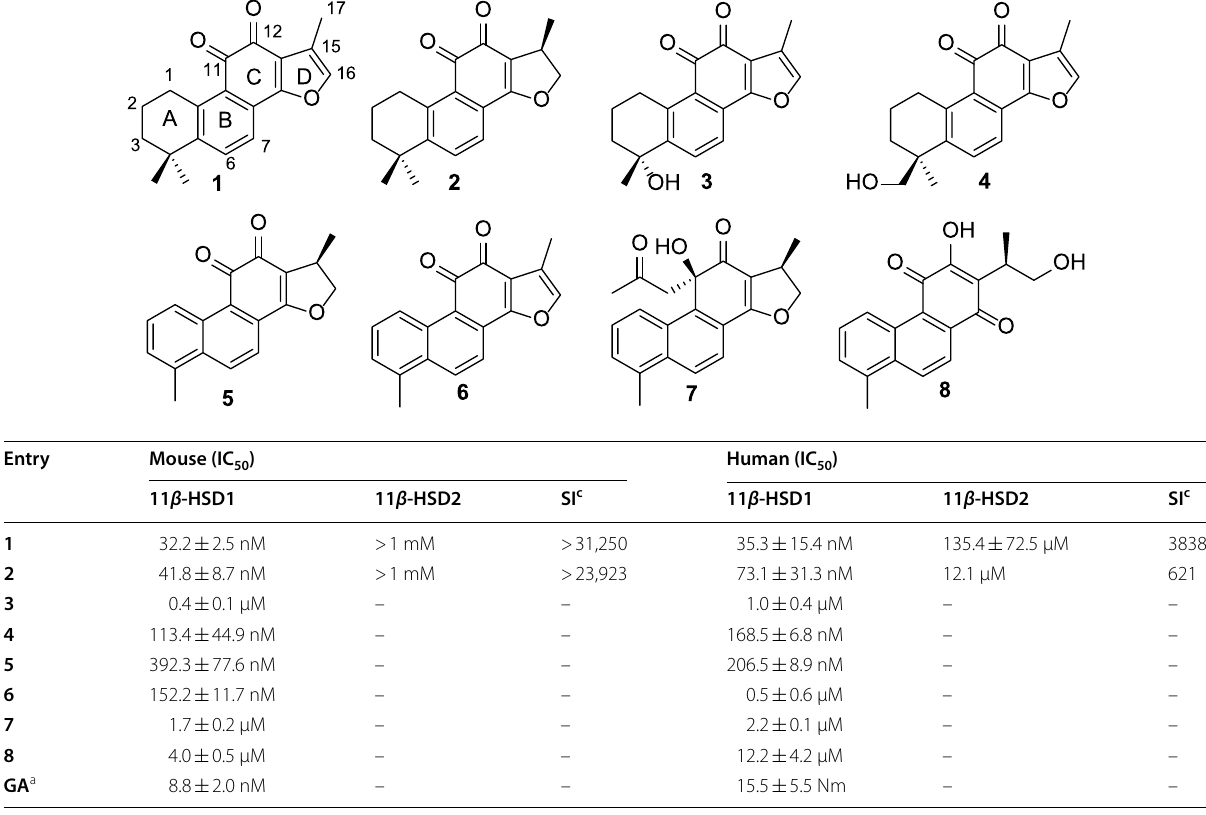
Values are averages of two determinations